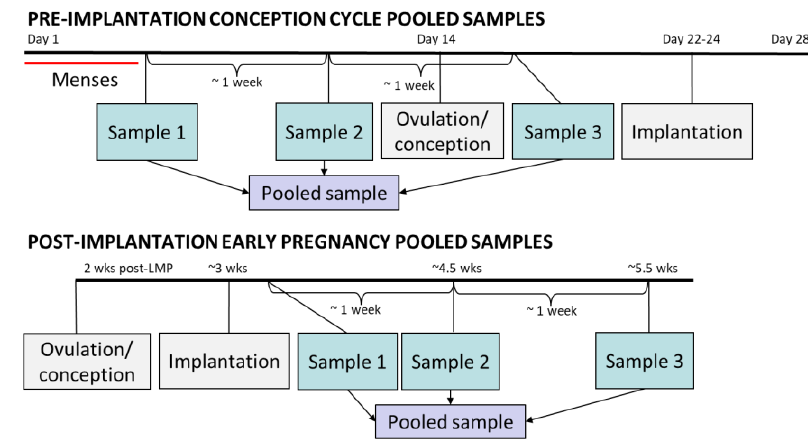
Figure 3. Pooled sampling strategy for pre- and post-implantation urine specimens. The pre- Pooled sampling strategy for pre- and post-implantation urine